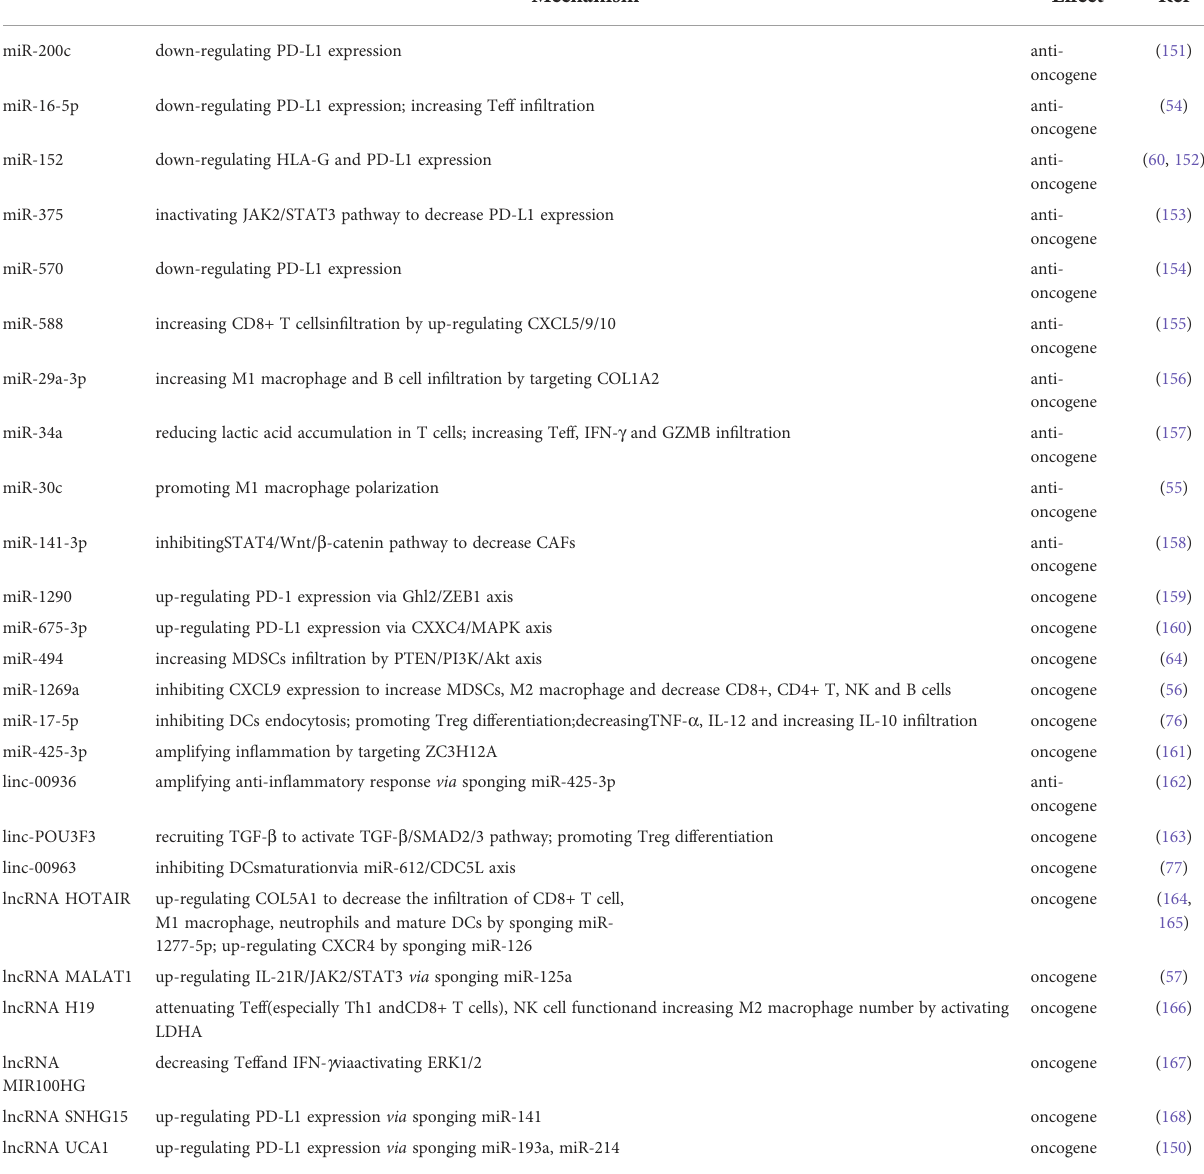
TABLE 2 Impact of epigenetic regulation on immune evasion in GC.